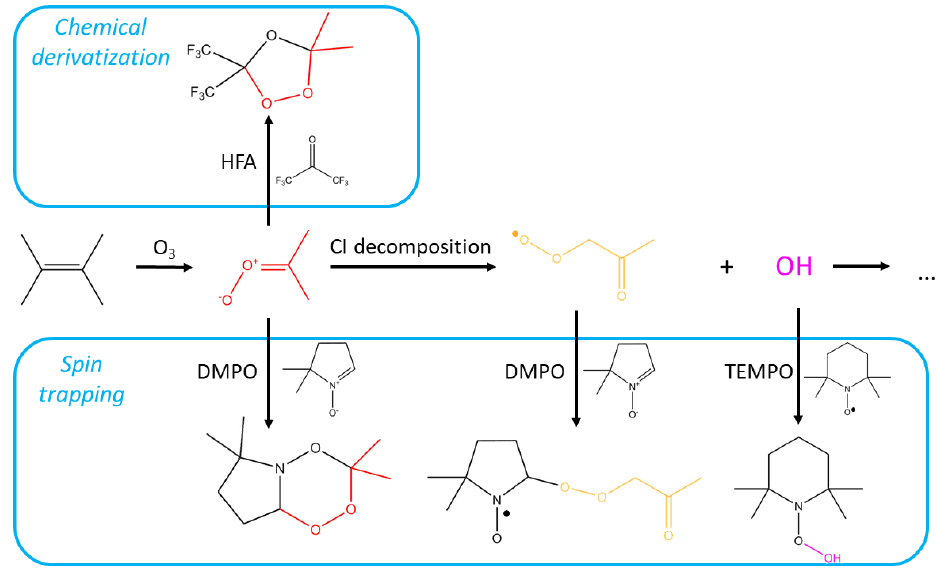
Figure 1. Mechanism of tetramethylethylene (TME) ozonolysis. Stabilized Criegee intermediate (shown in red) can be scavenged by the chemical derivatization agent HFA or the spin trap DMPO, or can decompose to the peroxy radical (shown in yellow) and OH. RO 2 and OH species can, in turn, react with spin traps. Reactions involving SCI are from MCM v3.3.1 (Jenkin et al., 1997) and Giorio et al.